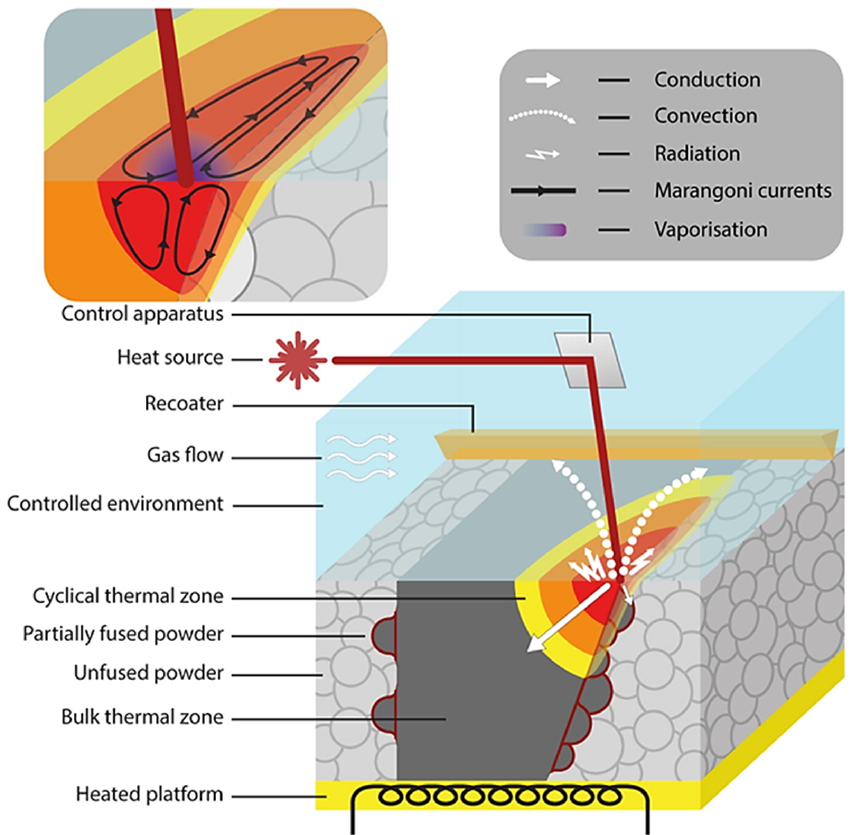
Figure 1. A schematic showing the complex thermal and fluid dynamics phenomena that occur in a powder bed fusion process. Reproduced from [9] with permission from Elsevier. The heat source can be a laser beam or an electron beam. In the latter case, the build platform is usually preheated. Due to the rapid freezing rates and other factors mentioned above, the AM microstruc- Microstructures resulting from solidification are a function of the heat extraction rate, tures significantly differ from those obtained in traditional processes (e.g., casting) in grain alloy chemistry, and nucleation conditions. They determine the properties (e.g., morphology distributions, defect populations and crystallographic texture [14,15]—a com- parison is provided in Figure 3 for a popular AM alloy, Ti6Al4V. Other alloys are considered elsewhere, e.g.,